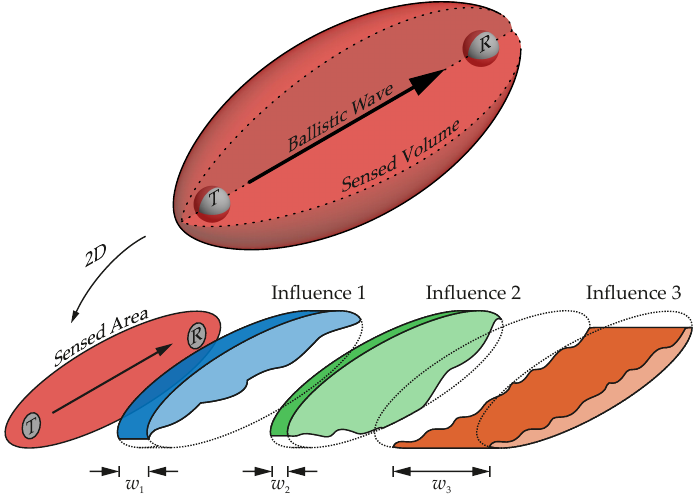
Figure 1. ( Top ): Simplified 3D representation of the volume scanned by US. ( bottom ): Model representation of different influences on the signal. The contribution of these influences to CWI characteristics depends on the affected region and a weighting